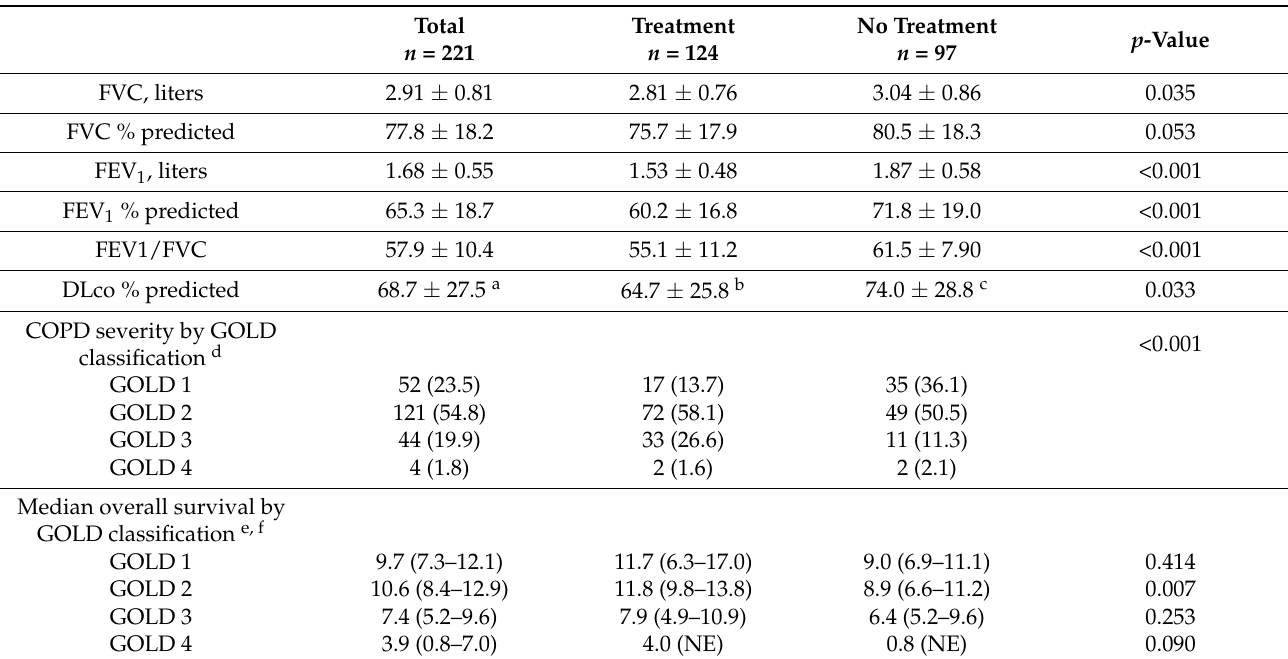
Table 2. Comparison of lung function by COPD treatment